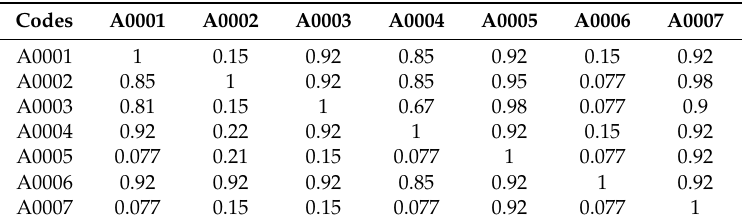
Table 5. Credibility Matrix.